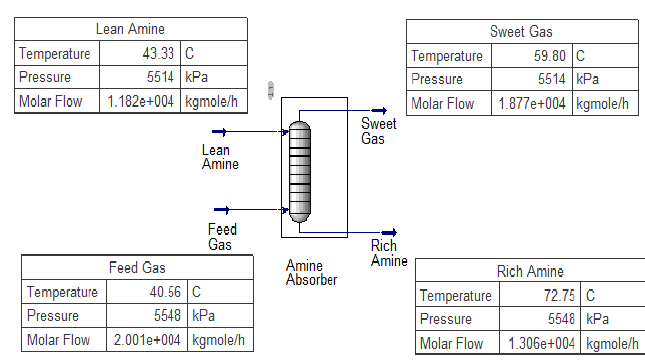
Fig. 1. NG treatment facility